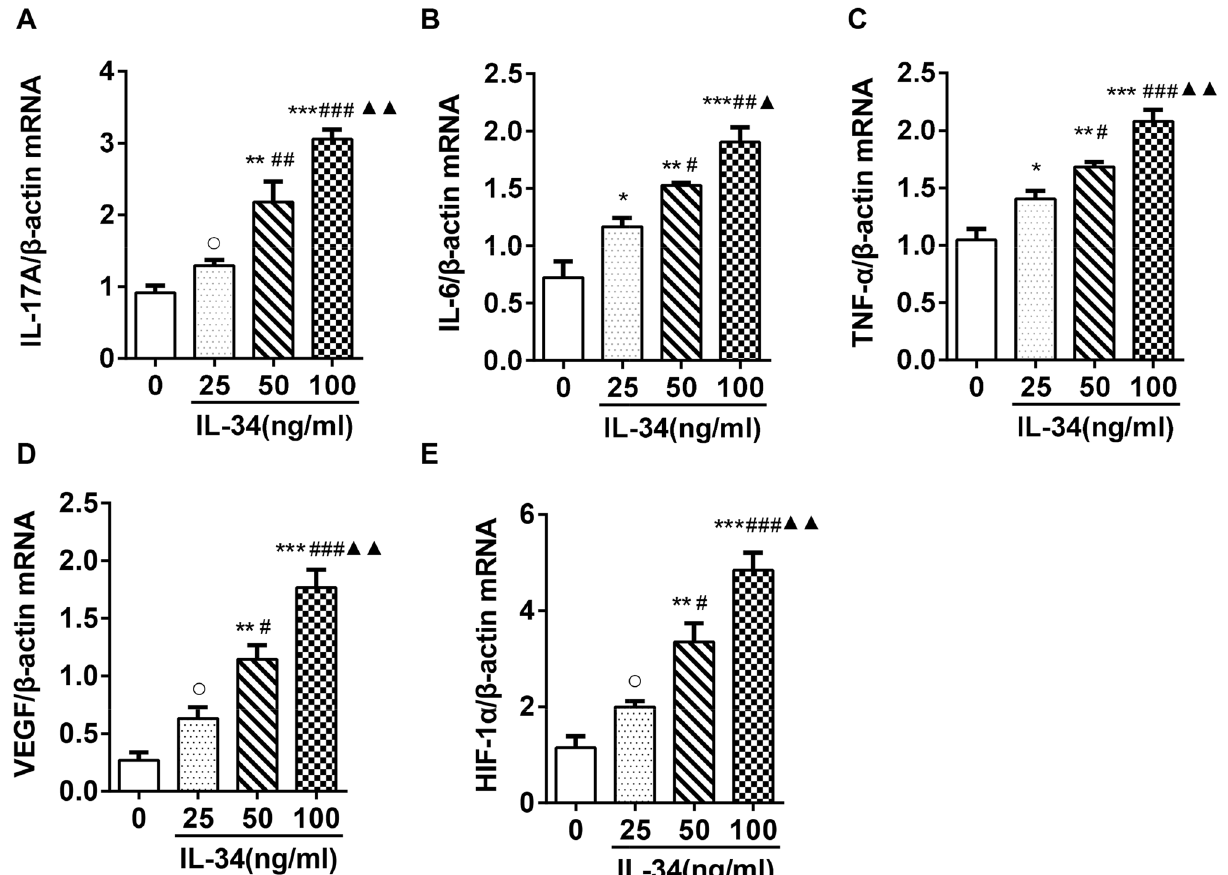
Figure 3. IL-34 upregulated the mRNA expression of IL-17A, IL-6, TNF-α, VEGF and HIF-1α in RA-FLSs. ( A–E ) RT-PCR was used to determine IL-17A,IL-6, TNF-α,VEGF and HIF-1α mRNA levels in RA-FLSs after treatment with IL-34 (0 ng/ml, 25 ng/ml, 50 ng/ml and 100 ng/ml). The differences between the four groups were tested by ANOVA. The data are expressed as the mean ± SEM. * P < 0.05, ** P < 0.01, *** P < 0.001 vs the 0 group; # P < 0.05, ## P < 0.01, ### P < 0.001 vs the 25 group; ▲ P < 0.05, ▲▲ P < 0.01 vs the 50 group; ○ P > 0.05 vs 0 the